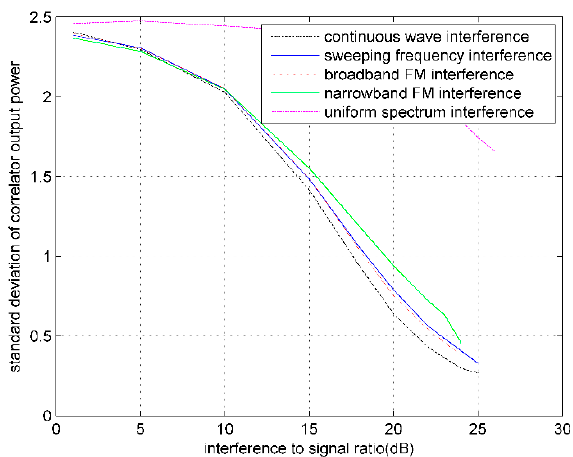
Figure 5. Influences of different RFIs on COP σ .